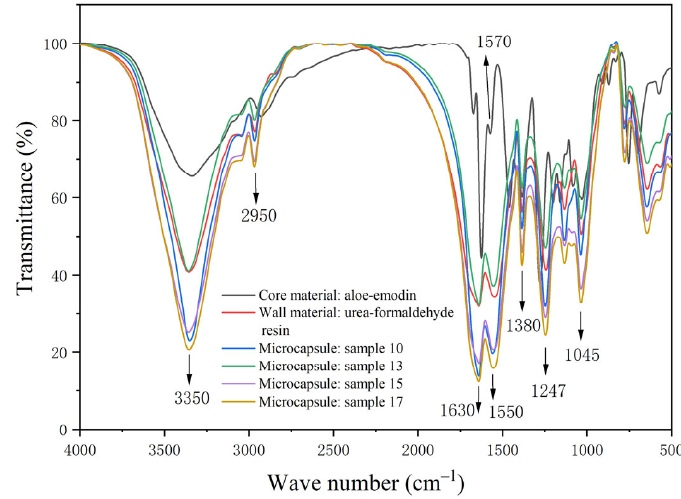
Figure 9. FTIR image of the core material, the wall material, and the microcapsules.